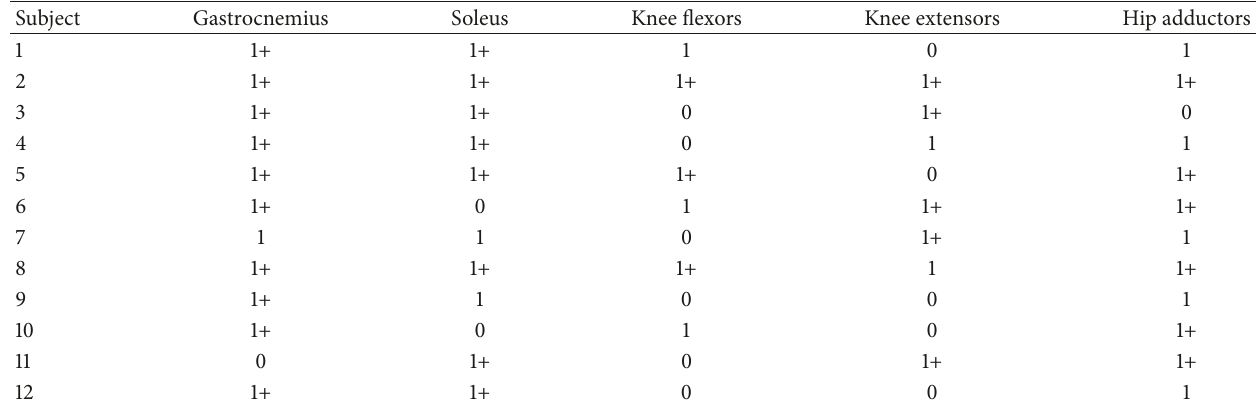
Table 3: Distribution of MAS scores in low spasticity